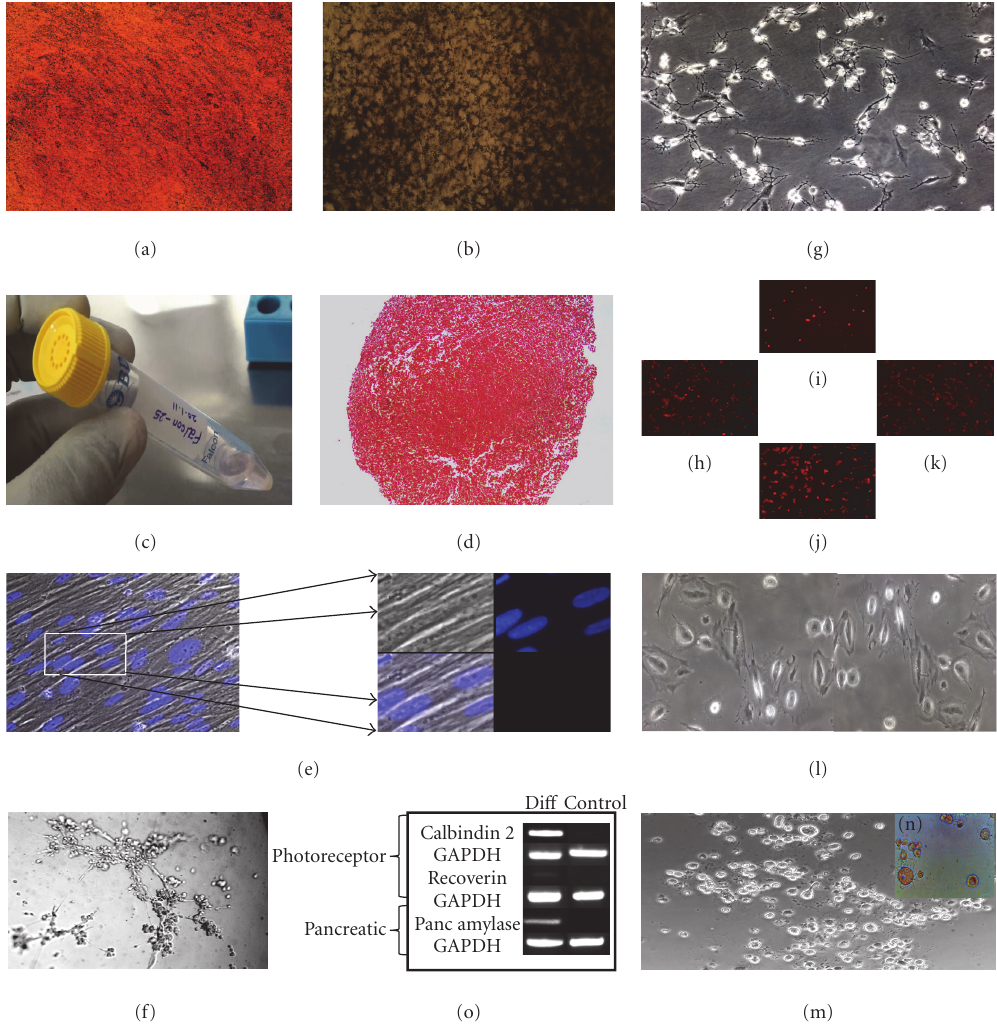
Figure 2: Pluripotency property of placental MSCs. (a) Oil red O staining (PhMSCsP5); (b) Von Kossa staining (PhMSCsP10); (c) “Falcon 25” static micromass cell culture system for chondrocyte di ff erentiation; (d) sa ff ranin O staining (PhMSCsP5); (e) hoechst 33342 staining of myotubules; (f) tubular assay; (g) neural di ff erentiation of placental MSCs (PhMSCsP20); (h) map2 staining (PhMSCs021P15); (i) NeuN staining (PhMSCsP15); (j) GFAP staining (PhMSCs021P15); (k) Neural filament staining (PhMSCsP15); (l) Retinal cell di ff erentiation of placental MSCs (PhMSCsP9); (m) Pancreatic progenitor cell di ff erentiation of placental MSCs (PhMSCsP9) (n) dithizone (DTZ) positive pancreatic progenitor cells; (o) PCR analysis of ectodermal lineage (photoreceptor genes calbindin2 and recoverin) and endodermal lineage (pancreatic amylase